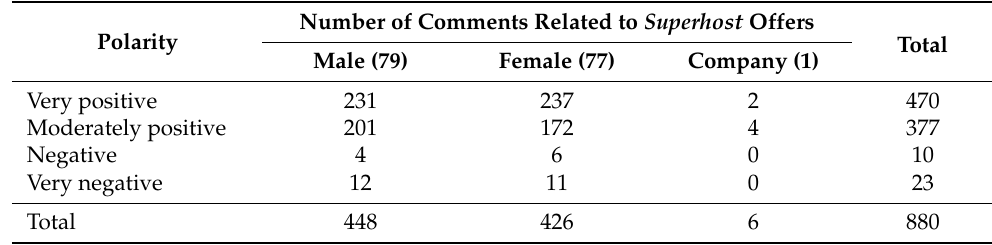
Table 3. Results of sentiment analysis of superhost offers.